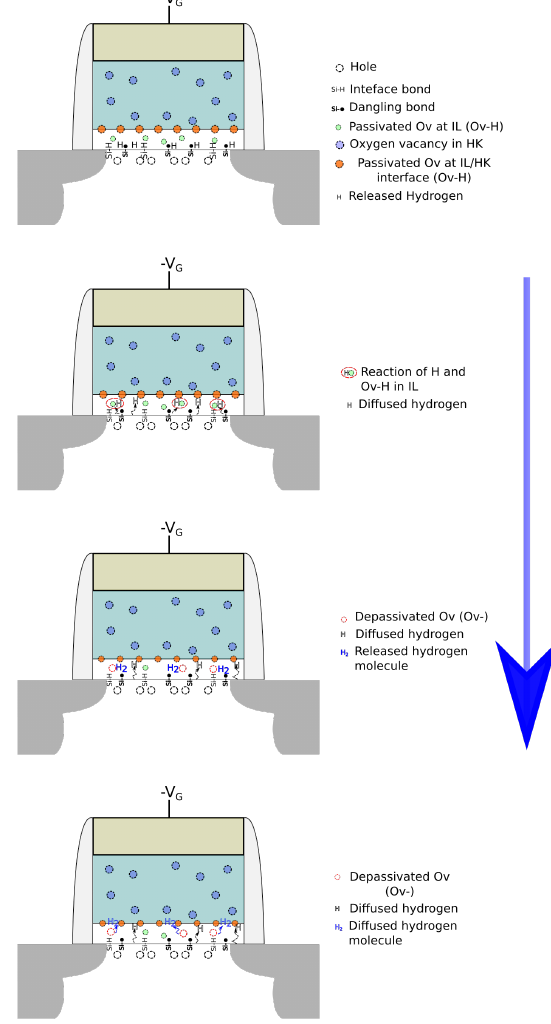
Figure 5. Degradation time evolution for NBTI interface traps’ generation. Ov, oxygen vacancy; IL, interface layer; HK, high- κ